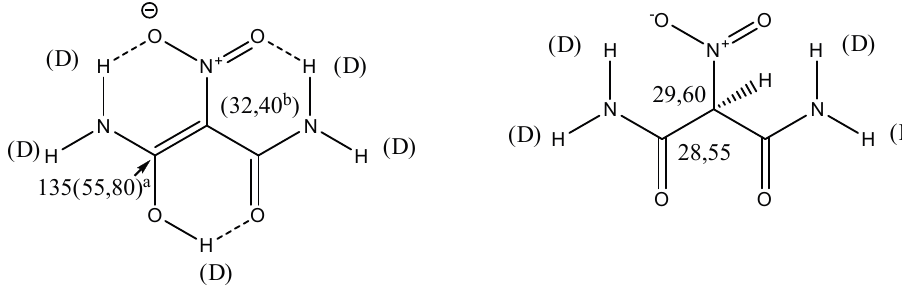
Figure 16. Deuterium isotope effects of nitromalonamide.